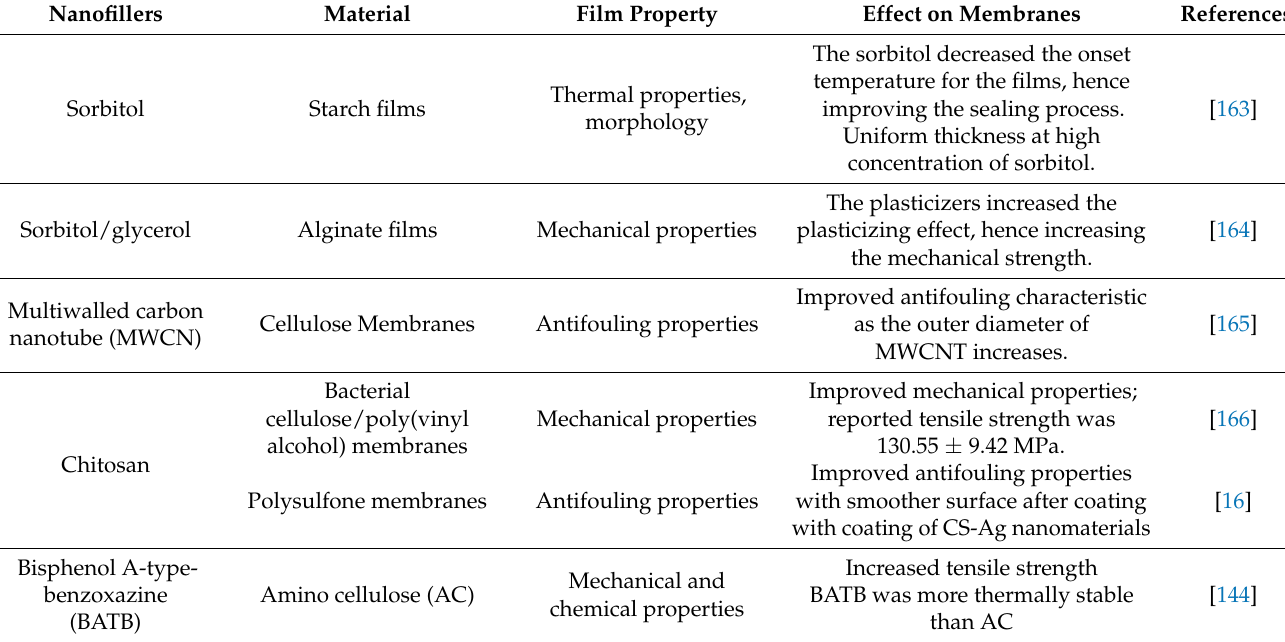
Table 3. The effects of nanofillers on biopolymeric and synthetic membranes’